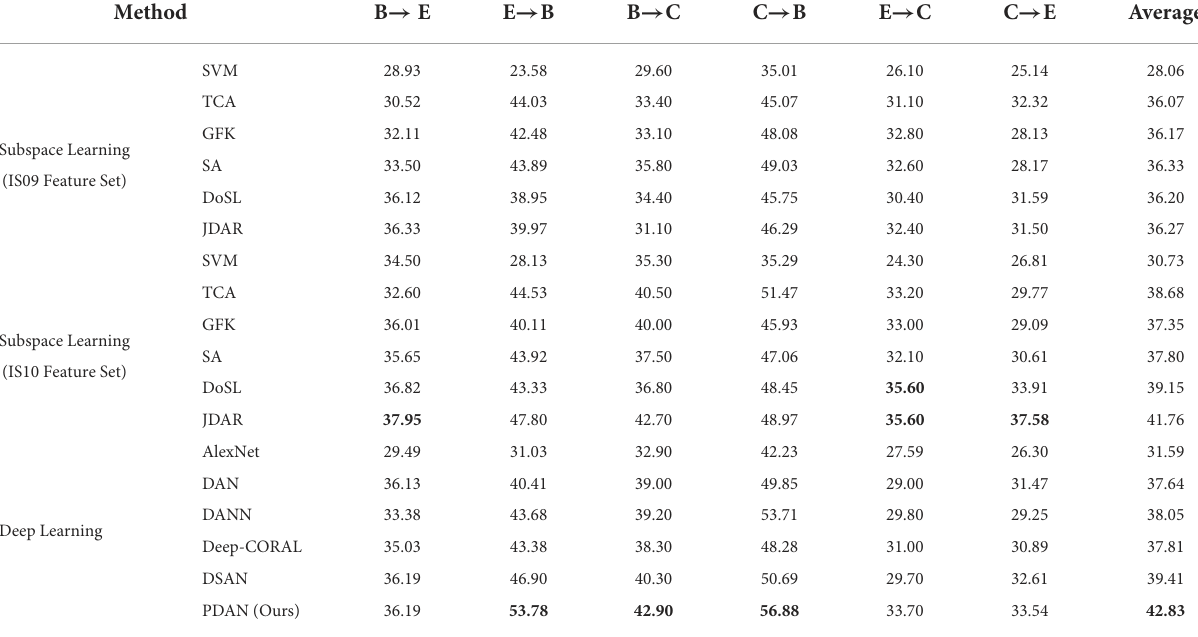
TABLE 2 The experimental results of all the transfer learning methods for six cross-corpus SER tasks, in which the best results are highlighted in bold.